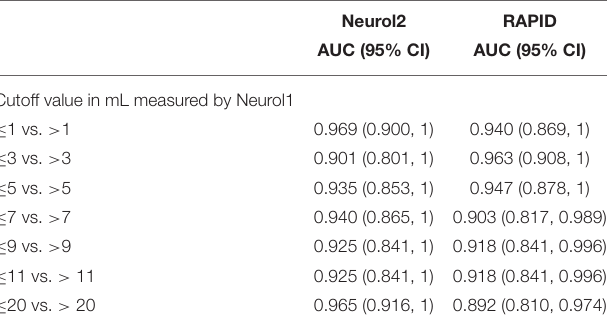
TABLE 5 | The AUC of receiver operated curves at different stroke volumes for vertebrobasilar stroke volumes with neurologist 1 as reference.